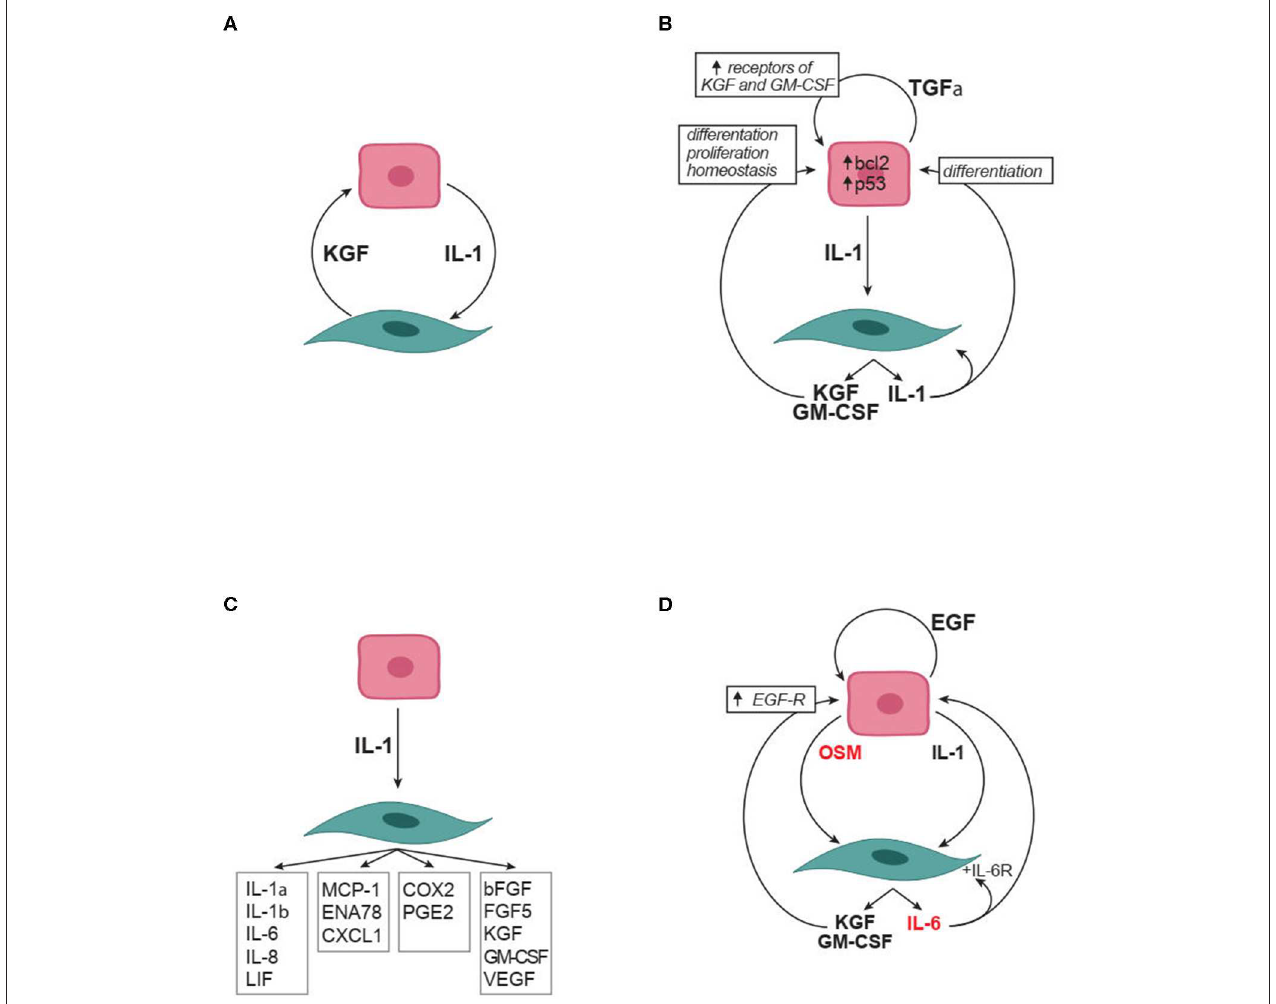
FIGURE 3 | Soluble factors in the crosstalk between keratinocytes and fibroblasts. (A) IL-1 and KGF are soluble mediators robustly identified as involved in the crosstalk. (B) Autocrine and paracrine effects relevant to IL-1 and KGF role in the crosstalk. (C) The many effects of keratinocyte produced IL-1 on fibroblasts. (D) Synergistic effect of IL-1 with IL-6 family members (in red) on the crosstalk. Arrowheads indicate enhancement. bFGF, basic fibroblast growth factor; COX2, Cyclooxygenase 2; CXCL, chemokine containing the CXC motif; EGF, epidermal growth factor which comprises multiple mediators including transforming growth factor- α , amphiregulin, heparin binding-EGF, and epiregulin; ENA-78, Epithelial neutrophil-activating protein 78; FGF, fibroblast growth factor; GM-CSF, granulocyte-monocyte colony stimulating factor IL, interleukin; KGF, keratinocyte growth factor (also known as FGF7); LIF, leukemia inhibitory factor; MCP-1, monocyte chemotactic protein-1; OSM, oncostatin M;PGE2, Prostaglandin E2; TGF, Transforming growth factor; VEGF, vascular endothelial growth